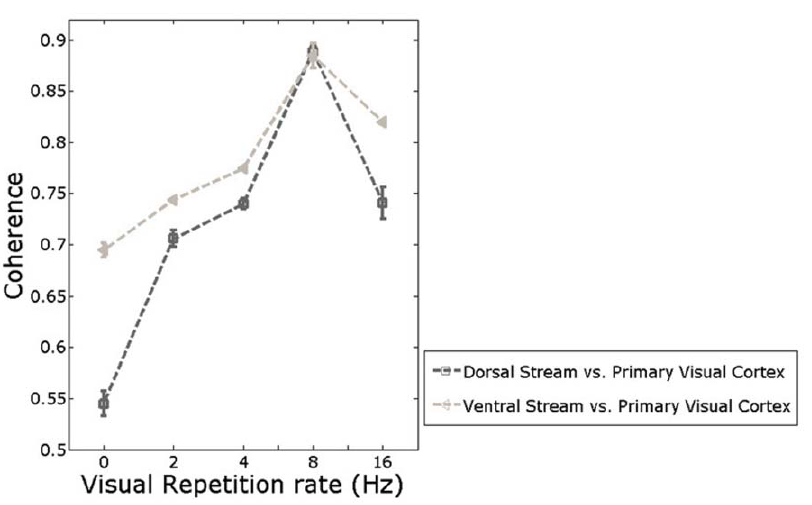
Figure 3. Impact of repetition rate on functional connectivity between two visual streams and primary visual cortex.